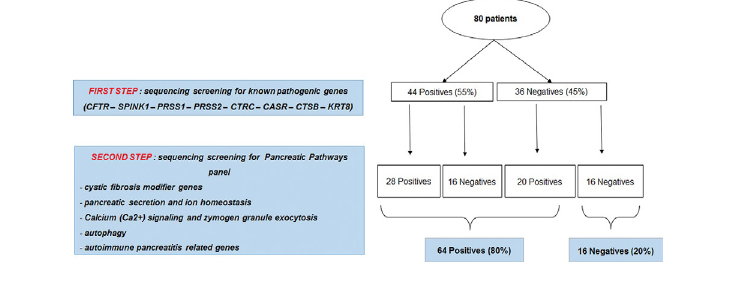
figure 1. Flowchart of the results of molecular analysis in 80 patients affected by recurrent/chronic